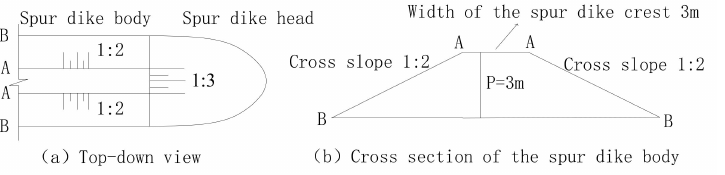
Figure 2. Sketch of submerged spur dike structure: ( a ) Top-down view of the spur dike; ( b ) Cross section of the spur dike